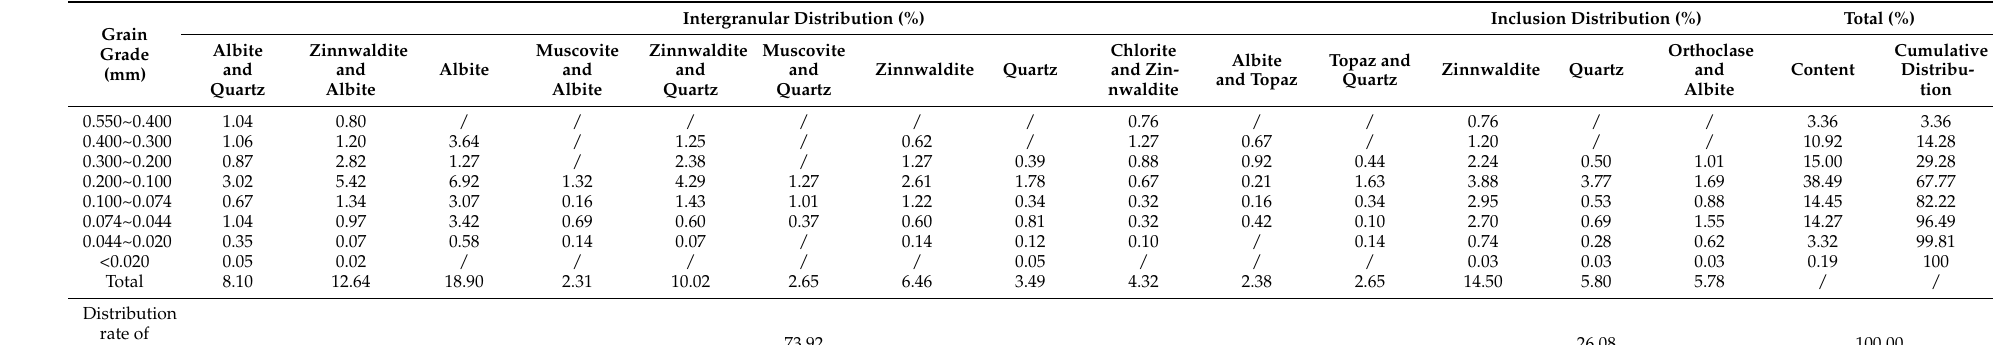
Table 4. Results of primary particle size and dissemination form of